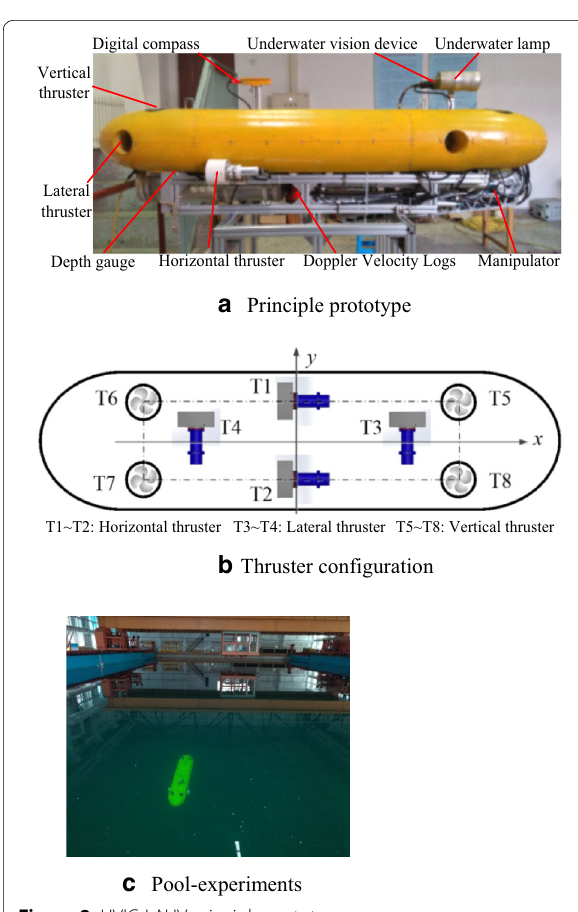
Figure 8 UVIC‑I AUV principle prototype